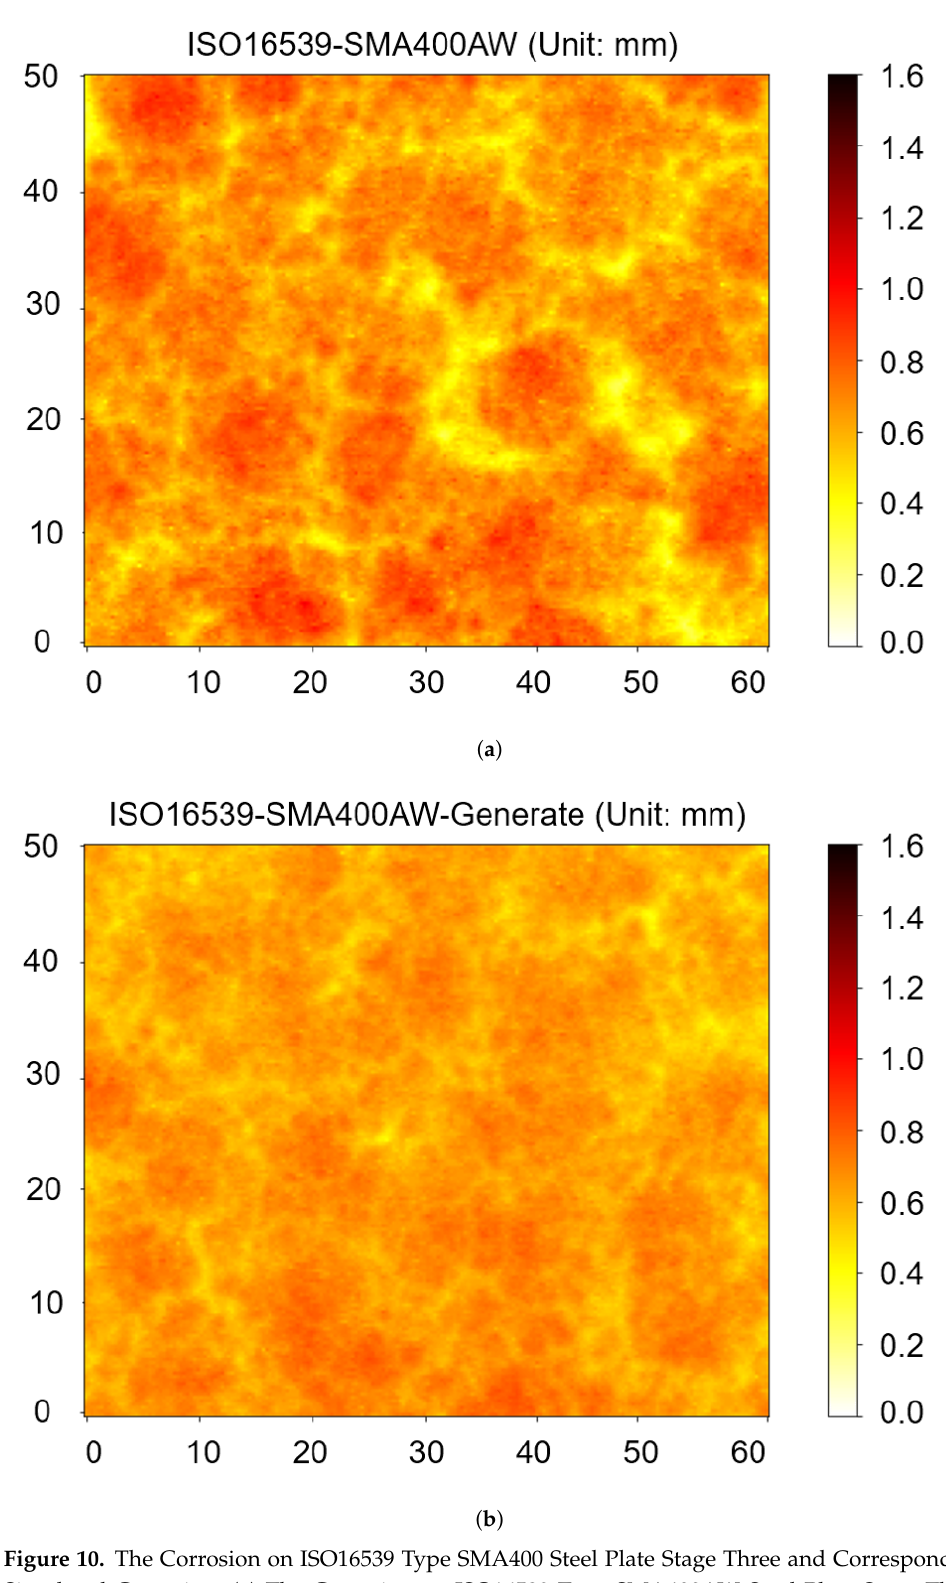
Figure 10. The Corrosion on ISO16539 Type SMA400 Steel Plate Stage Three and Corresponding Simulated Corrosion; ( a ) The Corrosion on ISO16539 Type SMA400AW Steel Plate Stage Three; ( b ) The Corrosion on Simulated Type SMA400AW Steel Plate Stage